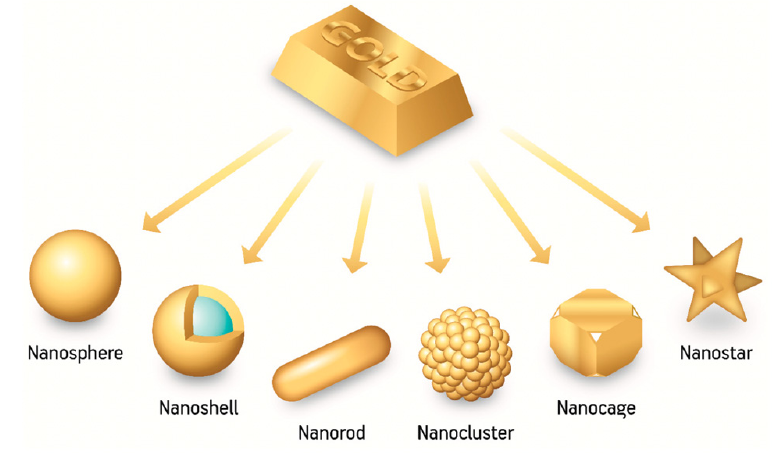
Figure 5. Different AuNP shapes [28].